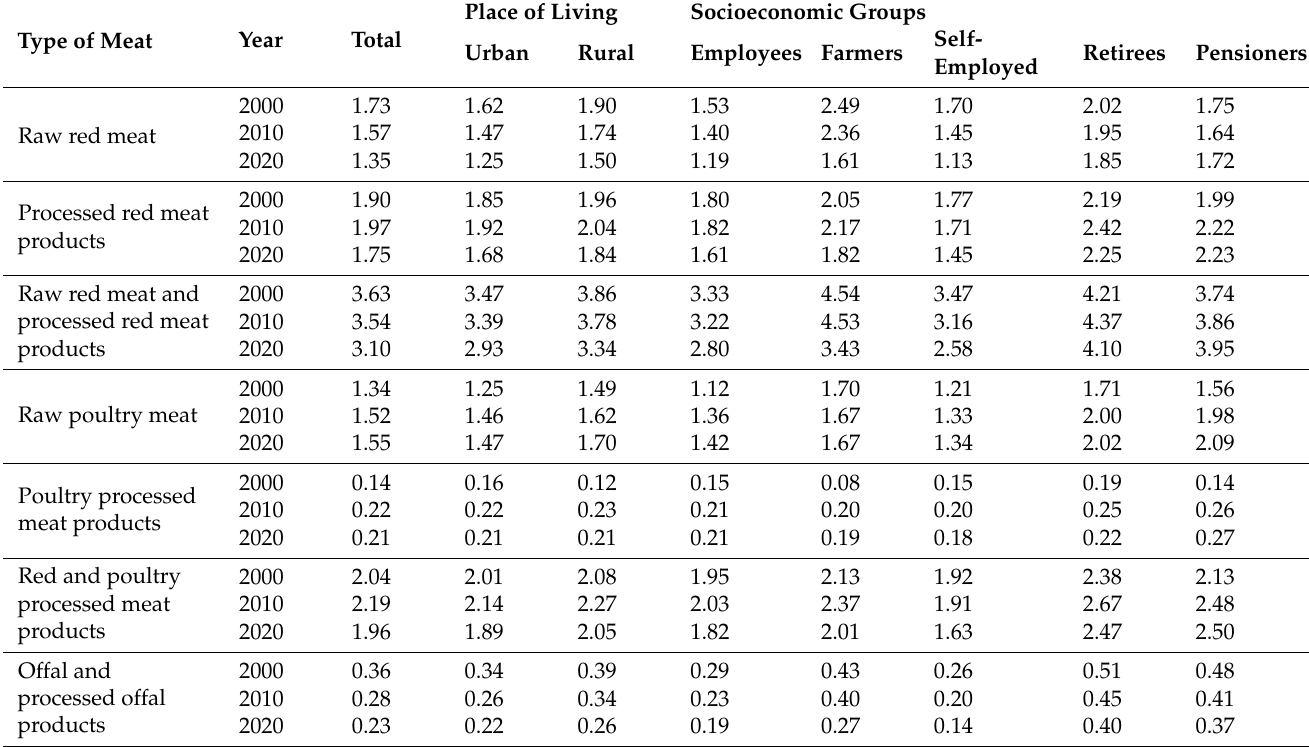
Table 1. The consumption of meat and meat products in Polish households in 2000, 2010, and 2020 with in terms of place of living and socio-economic groups